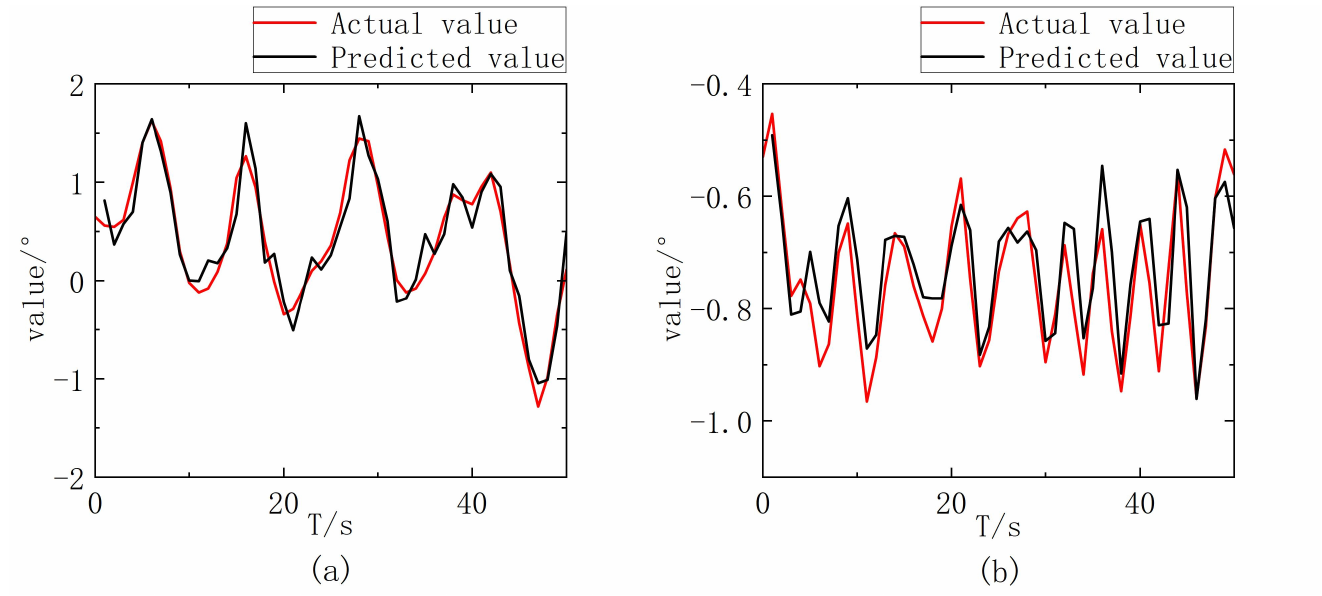
Figure 5. Ship motion attitudes: ( a ) ship’s roll angle; ( b ) ship’s pitch